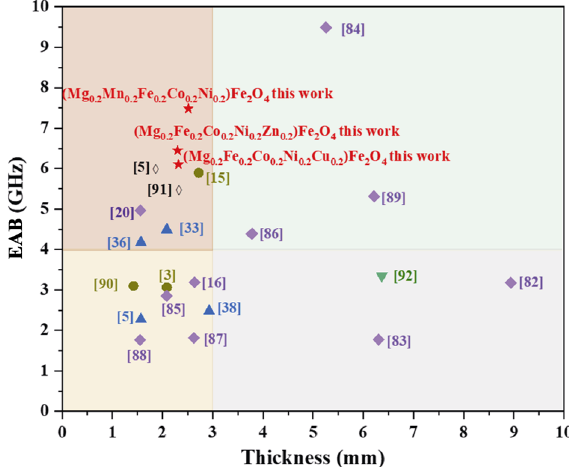
Fig. 11 EAB and corresponding thickness of HE MFe 2 O 4 samples and various kinds of reported EM